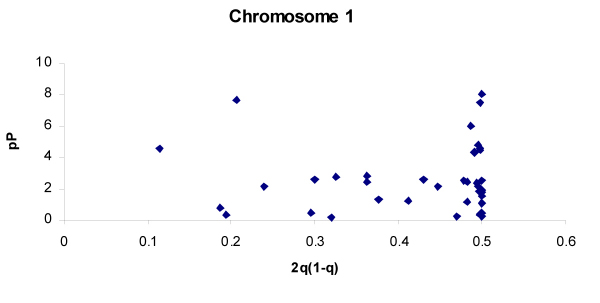
Plot of pP versus 2q(1-q).